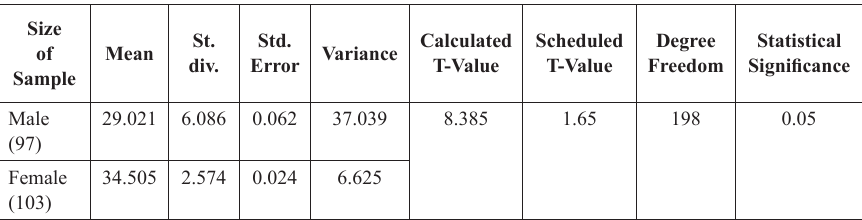
Table 6. The results of the T-test to measure the significance of the difference between the average real and hypothetical performance of the research sample